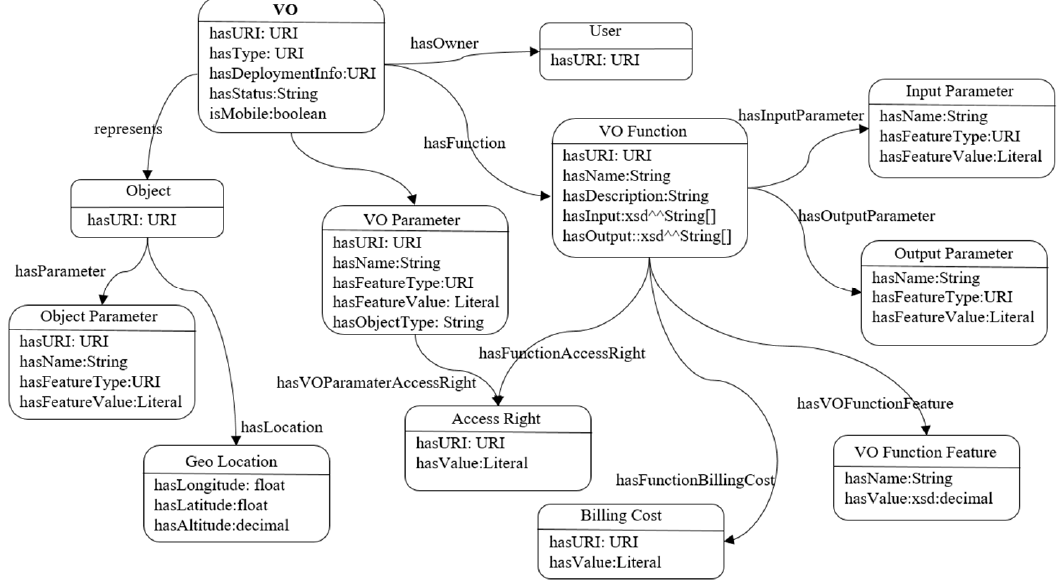
Figure 3. Virtual object (VO) information model.